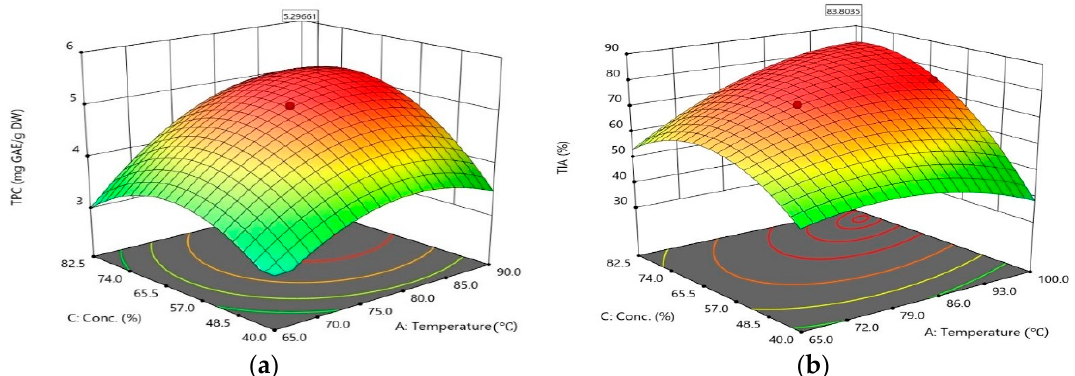
Figure 3. ( a ) Surface response curve on TPC of mealworm extract. Interactive effects of extraction temperature and ethanol concentration at fixed level of extraction time of 40 min; ( b ) Surface response curve on TIA of mealworm extract. Interactive effects of extraction temperature and ethanol concentration at fixed level of extraction time of 40 min.